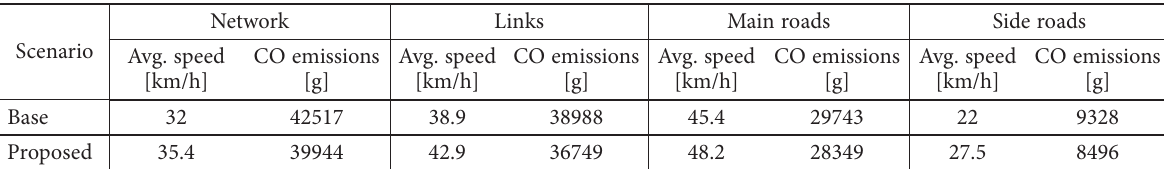
Table. Transportation system performance and related CO emissions (1 hour, morning peak) for base and proposed scenarios